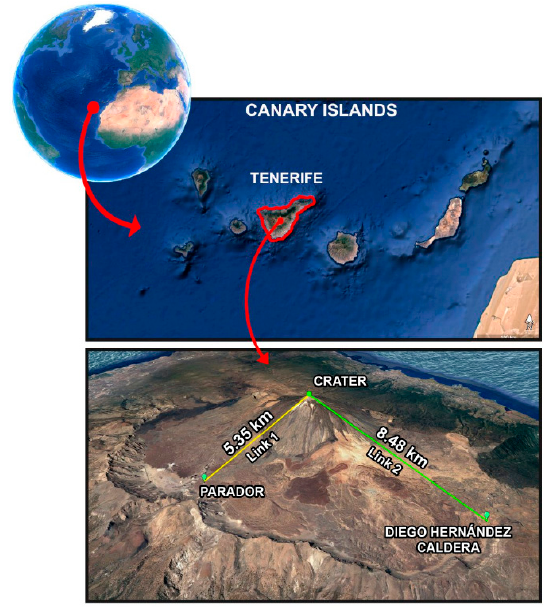
Figure 1. Tested links in Las Cañadas del Teide caldera.